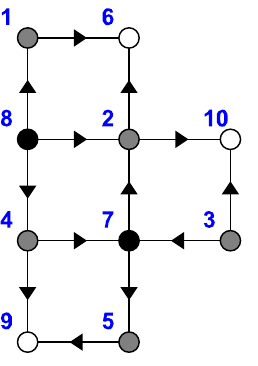
Figure 1: A digraph and its common out - neighbor